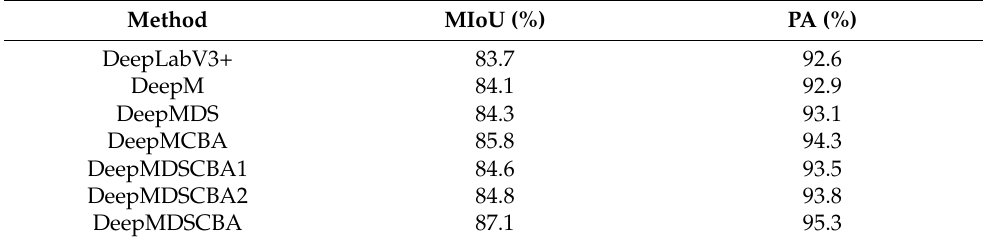
Table 15. Segmentation performance of ablation experiments.